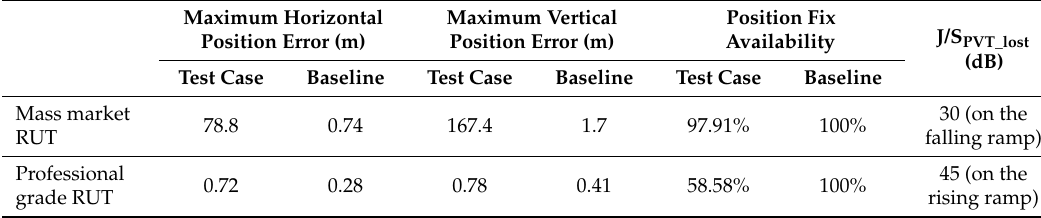
Table 6. Test results for MM and PRO RUT when default C/N 0 settings are